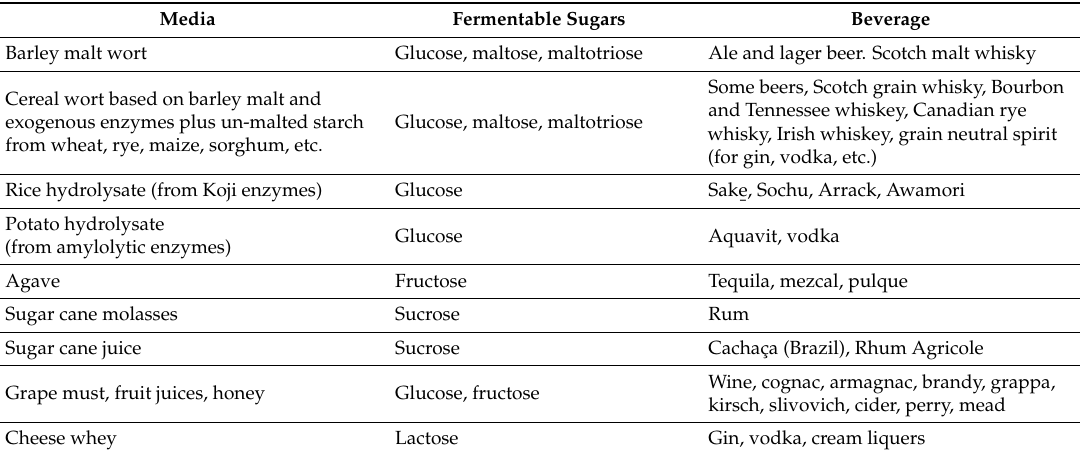
Table 2. Some fermentation media for alcoholic